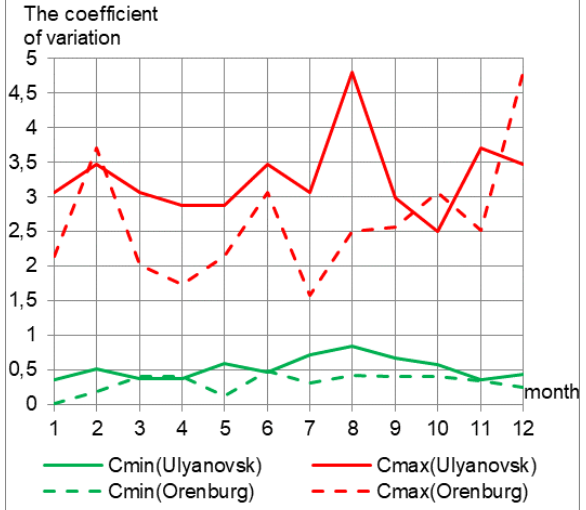
Fig. 2. Changes in the coefficients of variation of wind power calculated for the conditions of Ulyanovsk and Orenburg according to weather stations data of